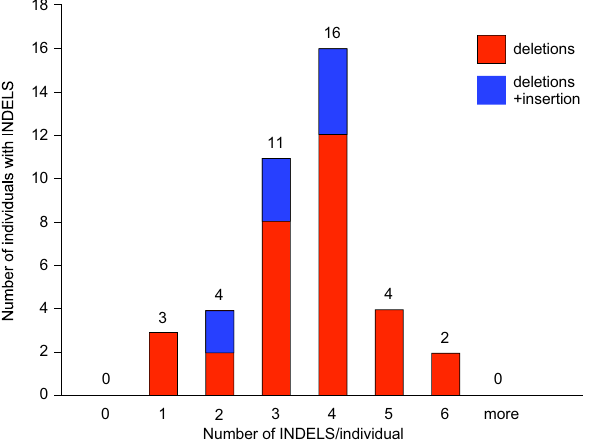
Figure 5. Occurrence of INDELS in individual CRISPants. The number of mutant alleles per individual was plotted. Red: deletions, Blue: insertions. 33 CRISPants contain three or more mutant alleles of the T/brachyury locus.